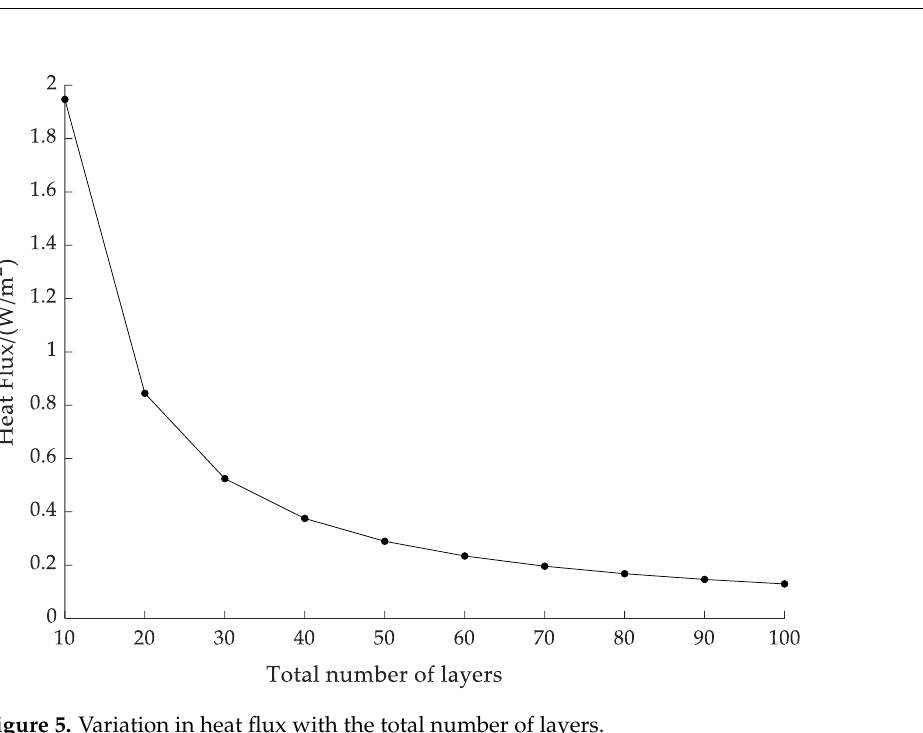
Figure 5. Variation in heat flux with the total number of layers.